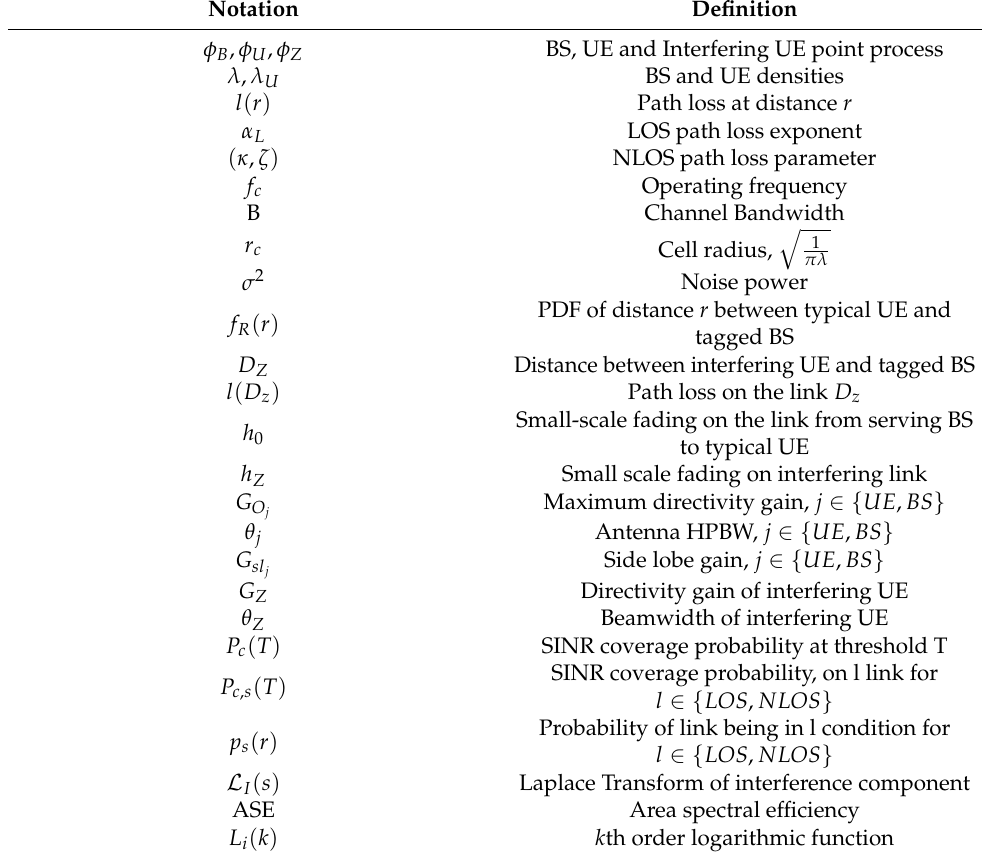
Table 1. List of notations and their